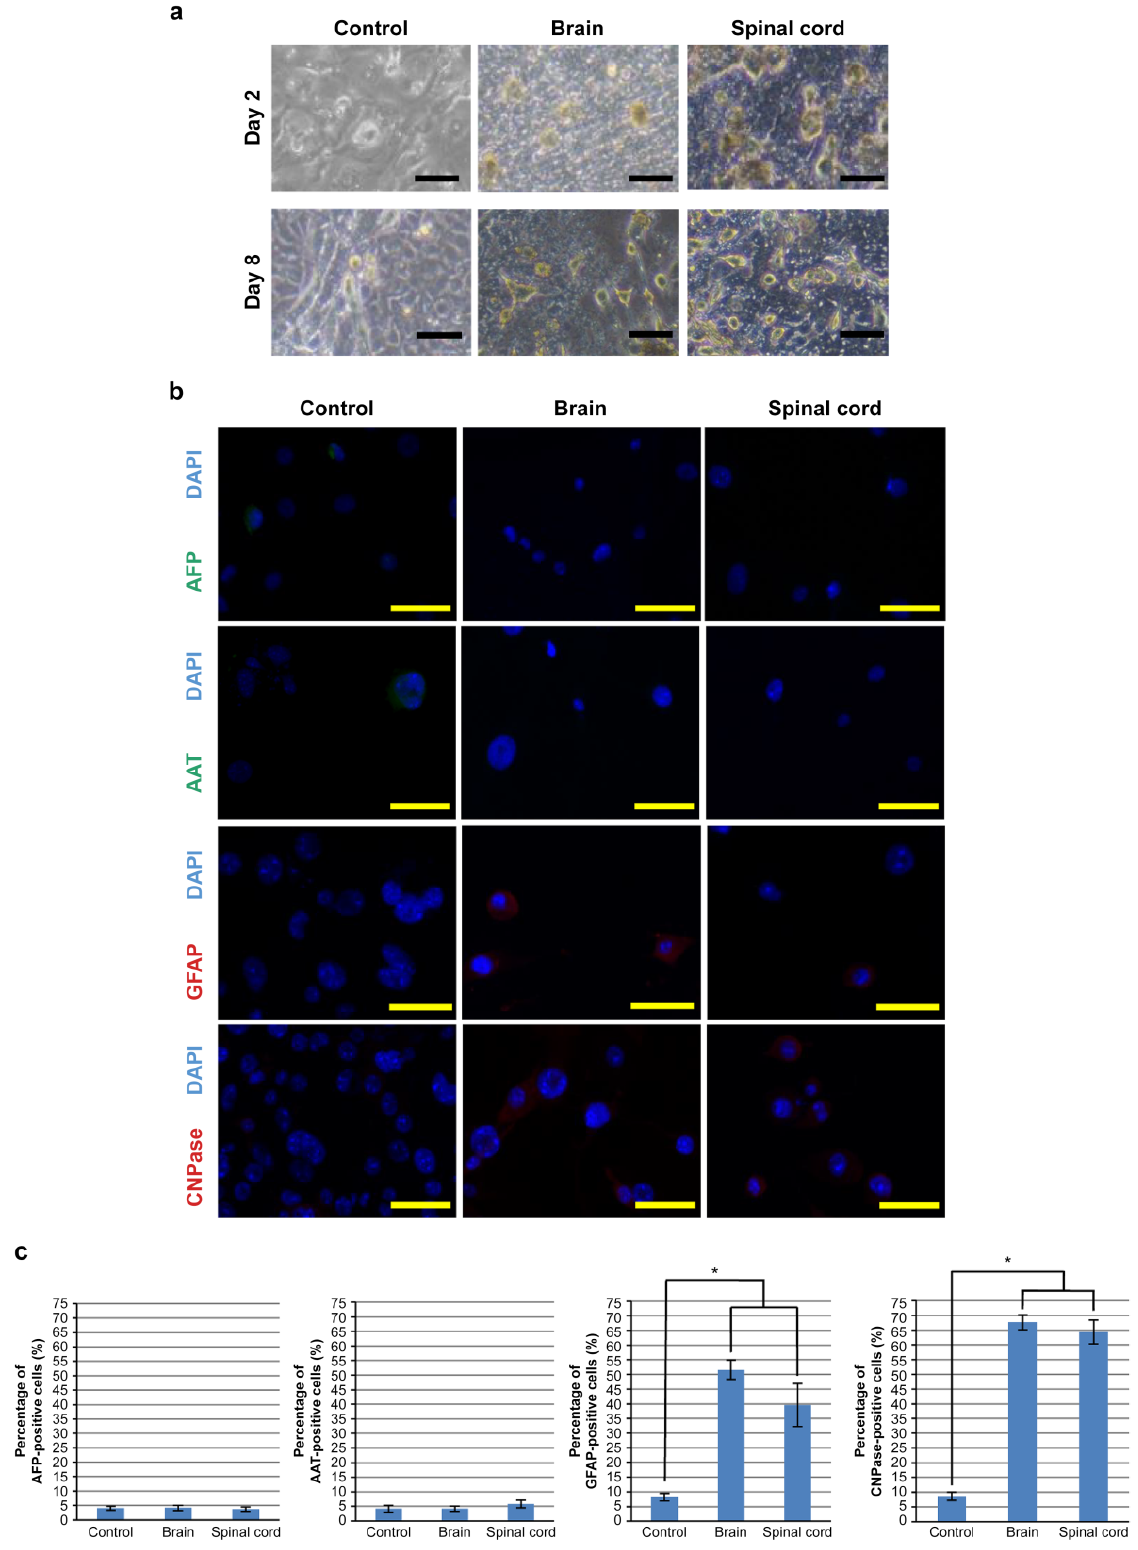
Figure 2. Analysis of the method for inducing differentiation of hOF-iPSCs cultured on frozen sections of the brain and the spinal cord. ( a ) Phase-contrast microscopy of the hOF-iPSCs cultured on cover glasses (as the controls) and frozen sections of the brain and the spinal cord. On day 2, all the hOF-iPSCs cultured on the cover glasses or the frozen sections were loosely spread. On day 8, the hOF-iPSCs cultured on the cover glasses exhibited various morphological changes, whereas the hOF-iPSCs cultured on frozen sections of the brain and the spinal cord exhibited neuronal morpho- logical traits. The cytoplasm in flat hOF-iPSCs was retracted toward the nucleus, forming a con- tracted multipolar cell body and membranous, process-like peripheral extensions. Cell bodies be- came increasingly spherical and refractile, exhibiting a typical neuronal perikaryal appearance. This tendency was observed in the cells from both sections of the brain and spinal cord. ( b ) Immunocy- tochemical analysis of hepatocyte-differentiated (AFP and AAT) and neuron-differentiated (GFAP and CNPase) markers in the induced hOF-iPSCs. DAPI was used as a counterstain. The hOF-iPSCs cultured on sections of the brain and the spinal cord exhibited higher GFAP and CNPase expression